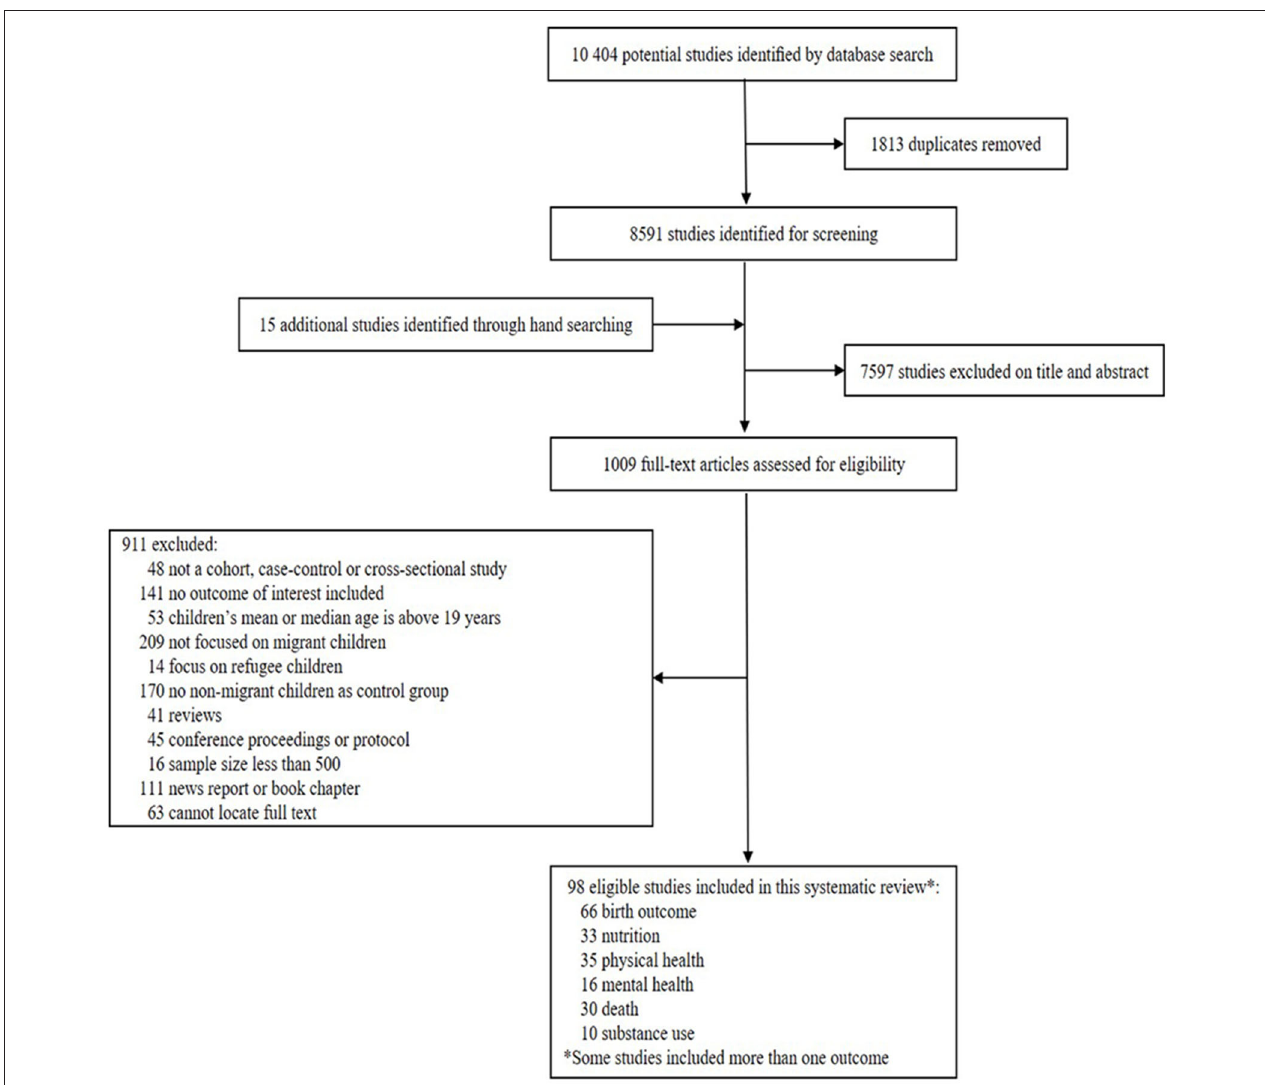
FIGURE 1 | PRISMA flow diagram. *Some studies included more than one outcome.